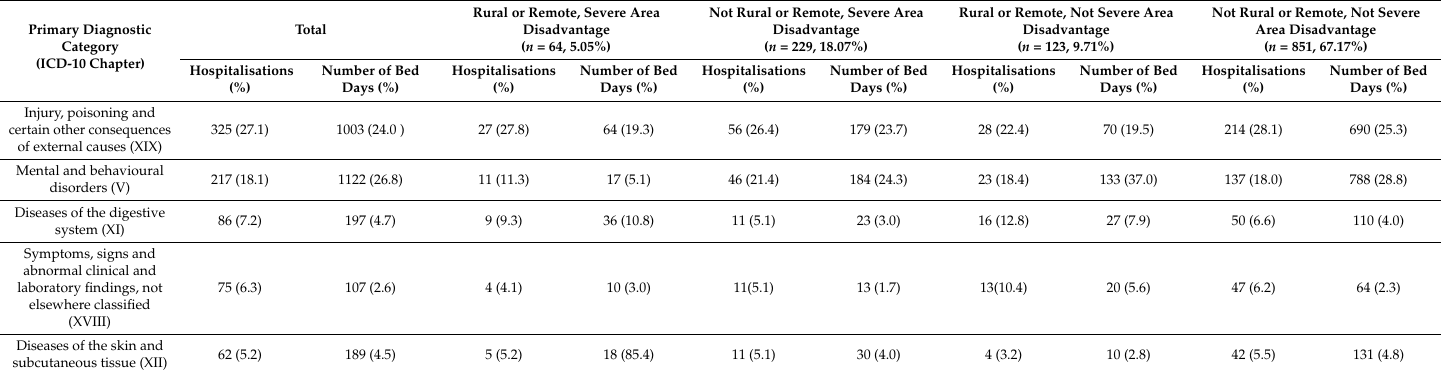
Table 4. Leading reasons for hospitalisation after release from prison, stratified by remoteness and area